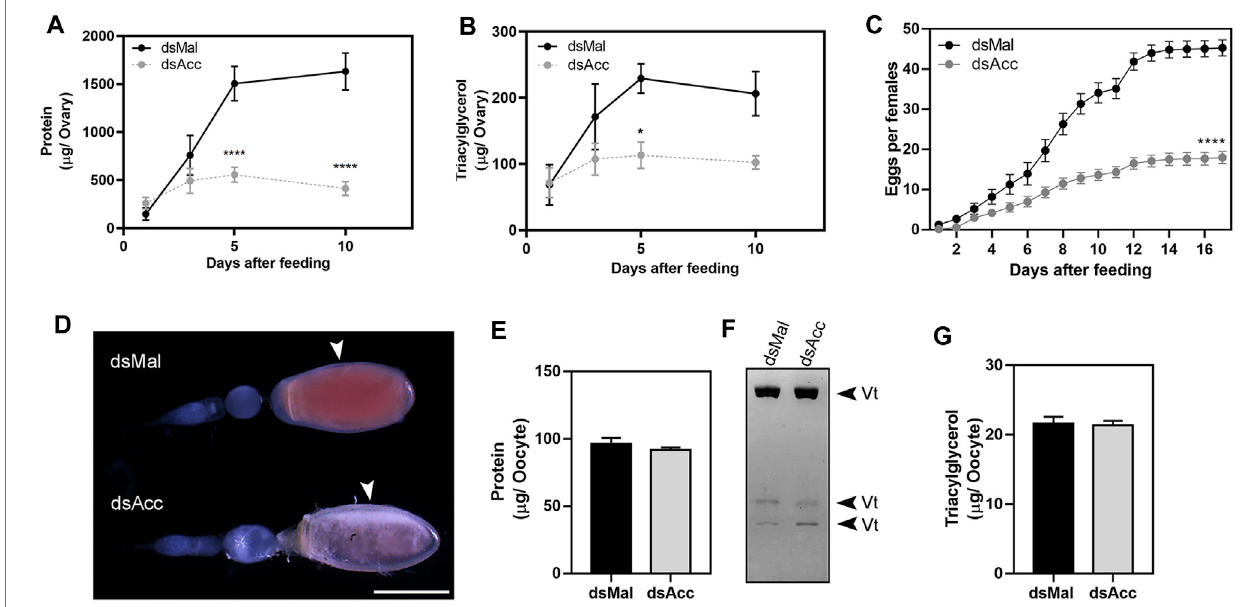
FIGURE 6 | Acc knockdown impaired reproduction. Starving adult females were injected with 1 µg of dsRNA for Acc or Mal (control) and were fed 3 days later. At days one, three, fi ve, and ten after blood meal, the insects were dissected, the ovaries were collected, and total contents of (A) proteins and (B) triacylglycerol were determined (n = 6). (C) After feeding, the cumulative oviposition was recorded (n = 35). (*) and (****): p < 0.05 and 0.0001, respectively, by two-way ANOVA followed by Sidak ’ s post-test. (D) Ovarioles dissected at day 12 after blood meal, from dsMal and dsAcc injected females, examined under a stereomicroscope. The arrowheads indicate the chorionated oocytes. Bar: 1.0 mm. (E) Total protein content in individual chorionated oocytes, dissected 11 – 13 days after feeding (means ± SEM;n=4). (F) Analysisofproteins presentinchorionatedoocytesbySDS-PAGE (7.5%polyacrylamide).Vt:vitellin. (G) Triacylglycerolcontentinindividualchorionated oocytes (means ± SEM; n =